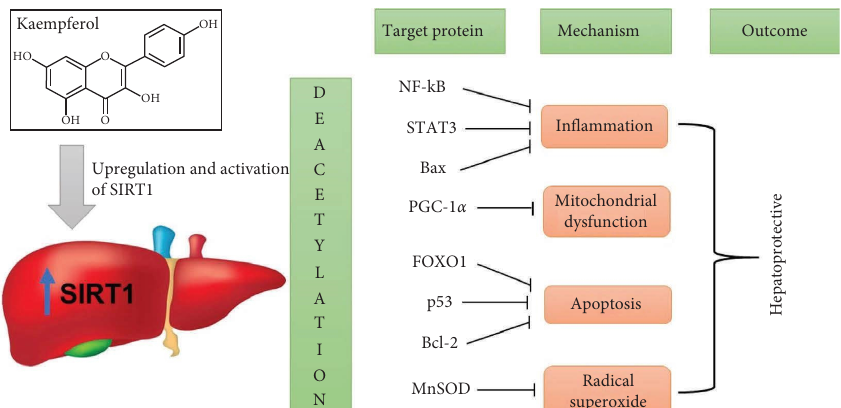
Figure 3: Upregulation and activation of SIRT1 in the liver by kaempferol. Te SIRT1 deacetylase activity and expression increases, which leads to inhibition of several transcription factors, such as infammation, mitochondrial dysfunction, apoptosis, and radical superoxide, in the liver tissue. Inhibition ( ⟞